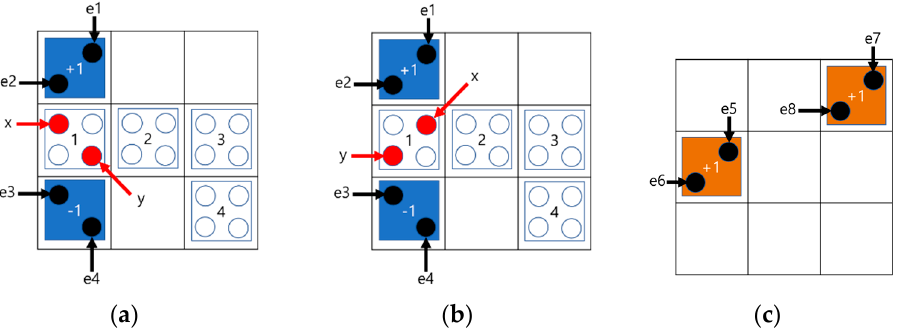
Figure 13. Location of electrons and cells for physical proof of the proposed XNOR gate: ( a ) Layer 1: cell 1 = − 1 ( b ) Layer 1: cell 1 = +1; ( c ) Layer 2.